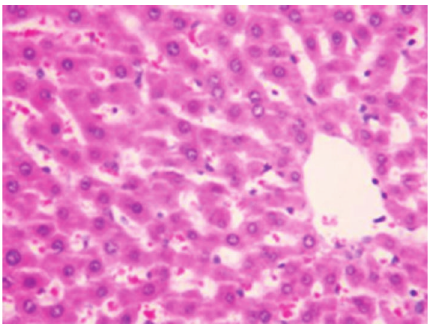
Figure 1: Sham-operated group 28 days; normal liver cells; HE × 200.